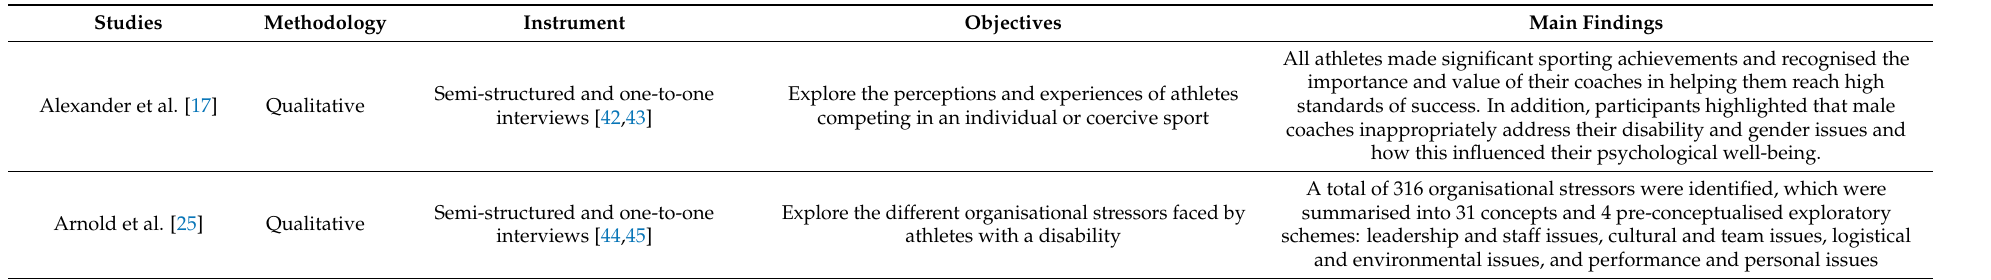
Table 4. Methodology, objectives, and main findings of the studies included in the systematic